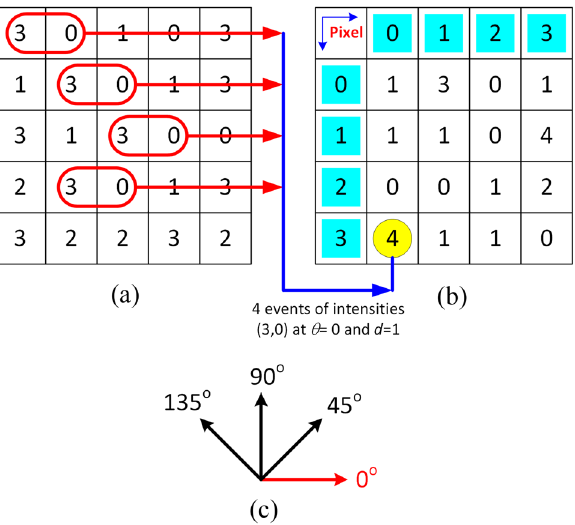
Figure 6. A simple diagram for GLCM computation; ( a ) input matrix, ( b ) GLCM computed from ( a ) using d = 1 at 0° orientation, and ( c ) set of orientation, θ .